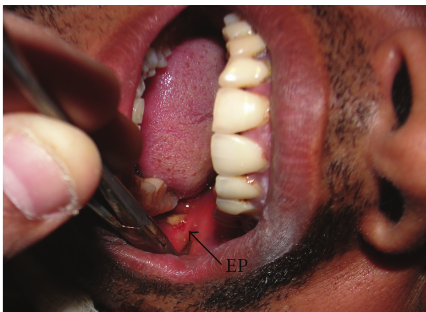
Figure 1: Preoperative photograph showing the entry point (EP) of the bullet (1.2cm × 1.0 cm) on the cheek mucosa adjacent to the left lower third molar.